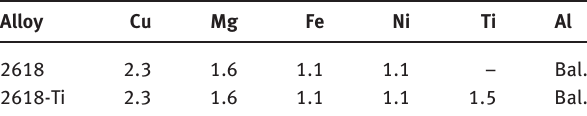
Table 1: Nominal composition of the studied alloys (mass%).